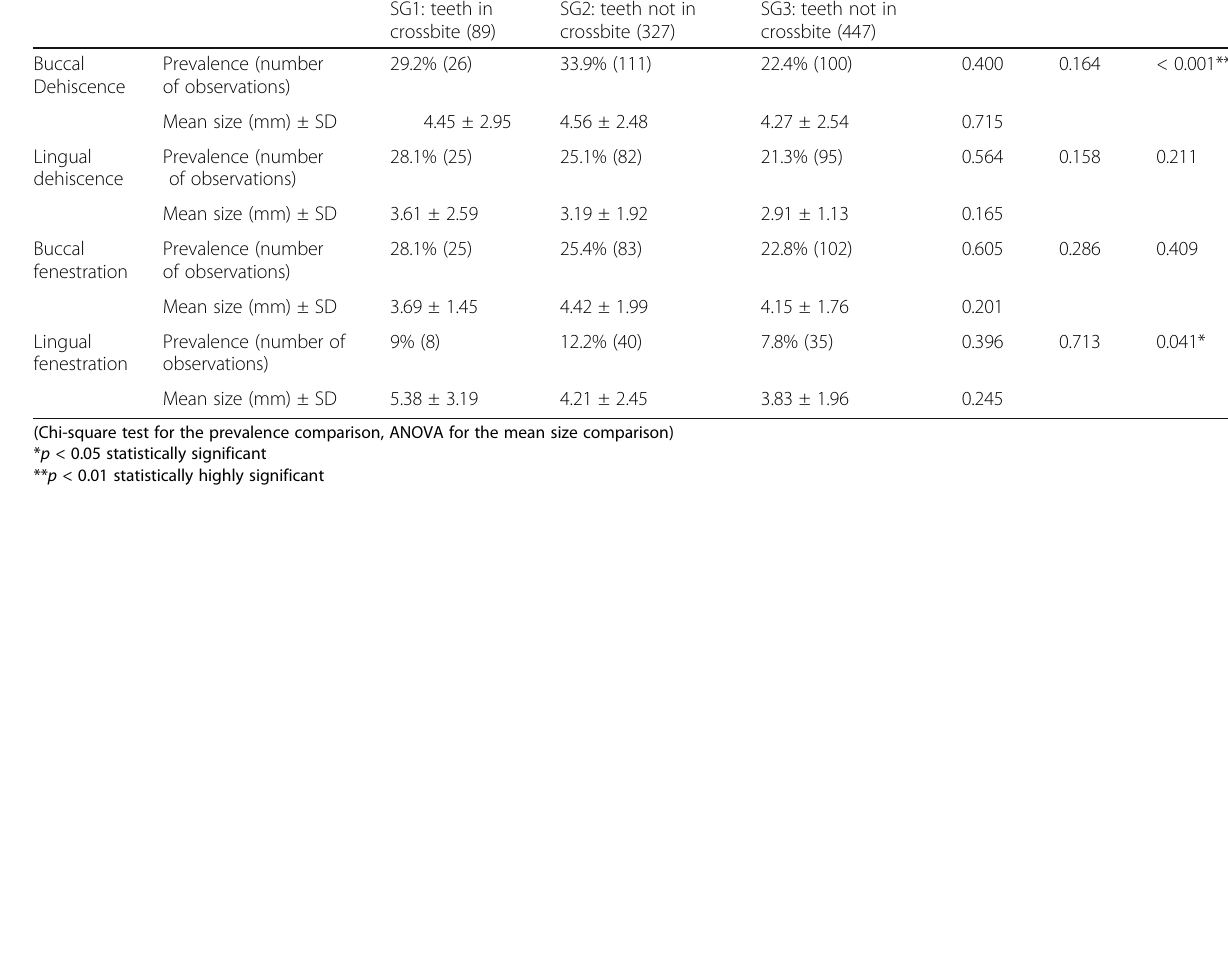
Table 13 Comparison of bony defect prevalence between the buccal and lingual sides. Teeth in edgebite were excluded Dehiscence prevalence (number of observations)